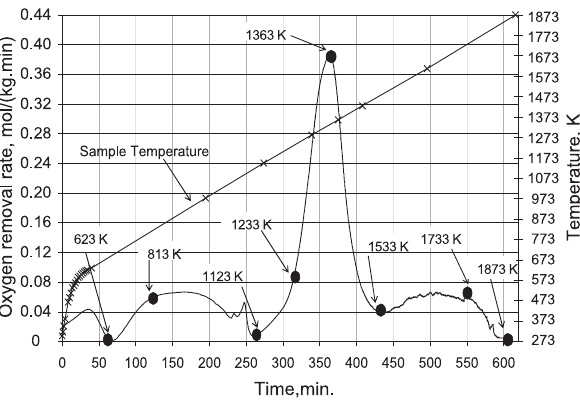
Fig. 1: Temperature programmed reduction of primary ilmenite in the H -N gas mixture. Temperature was ramped from 623 to 1873 K at 2 2 2 K/min. Samples in the highlighted points were examined by LECO and